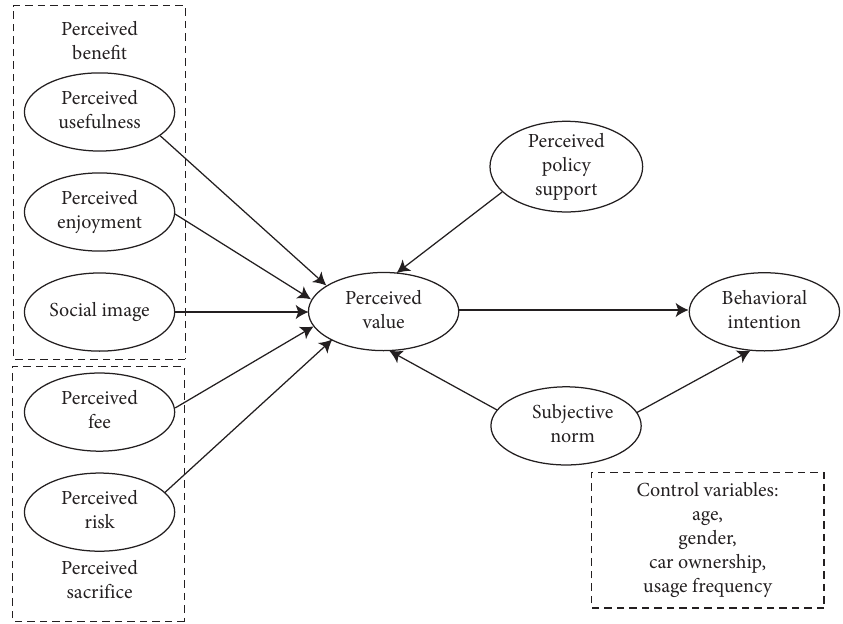
Figure 1: Research